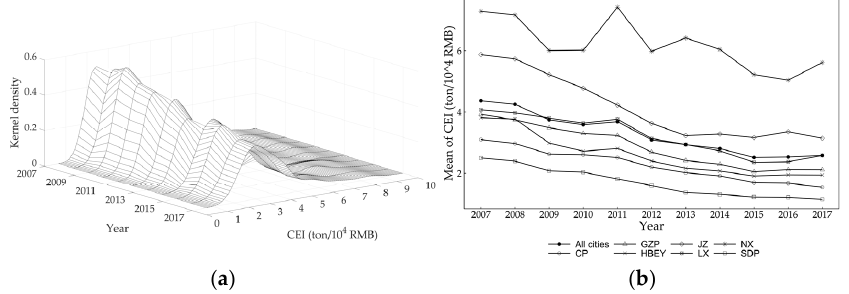
Figure 2. Temporal evolution characteristics of the CEI of urban agglomerations in the Yellow River basin from 2007 to 2017. ( a ) Kernel density curve. ( b ) Changes in average CEI.